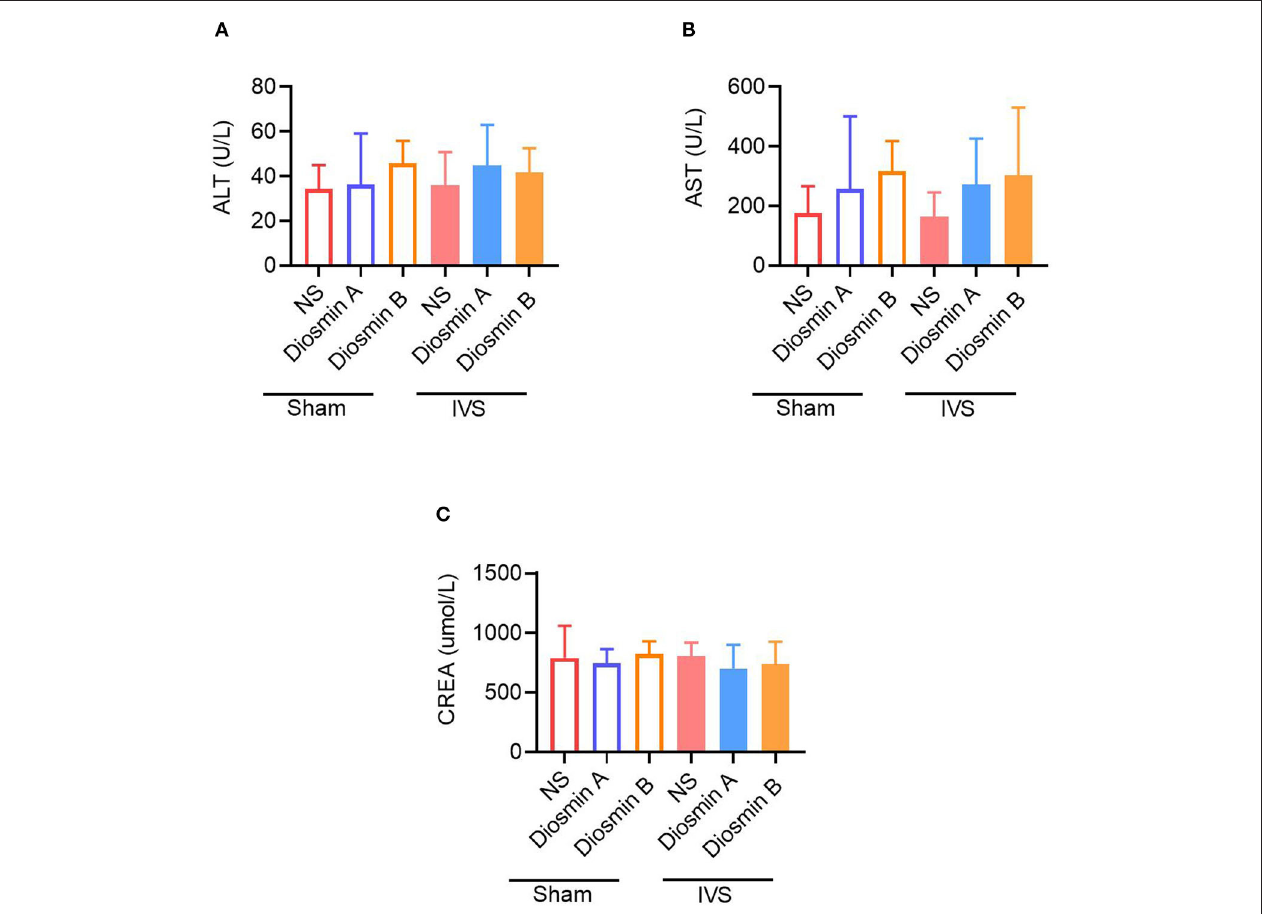
FIGURE 5 | The high purity of diosmin has no liver and kidney damage. The content of liver function index alanine aminotransferase (ALT) (A) and aspartate aminotransferase (AST) (B) renal function index creatinine (CREA) (C) in mice after administration of different purity of diosmin. Sham/NS ( n = 3), sham/diosmin A ( n = 3), sham/diosmin B ( n = 3), IVS/NS ( n = 6), IVS/diosmin A ( n = 7), and IVS/diosmin B ( n = 7). IVS, iliac vein compression.